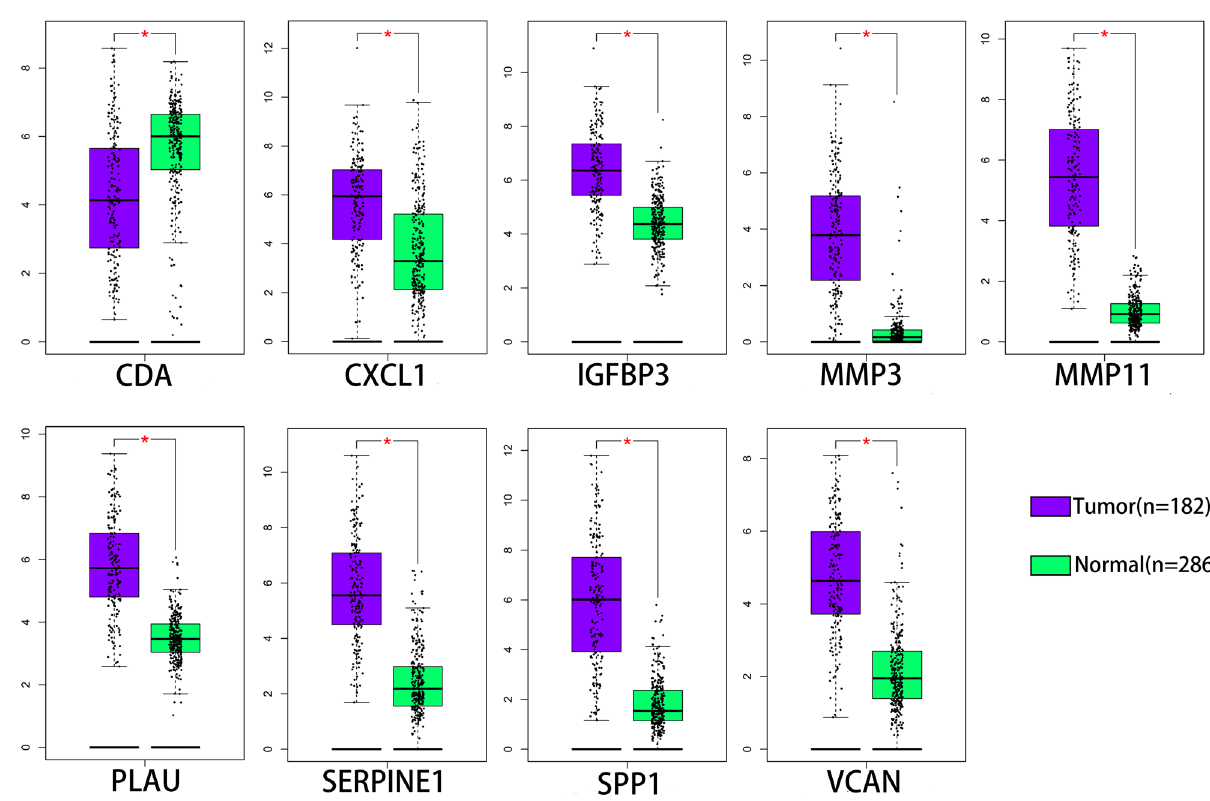
Figure 6. Expression of hub genes in ESCA tissues and normal tissues from the GEPIA database. ESCA, Esophageal carcinoma; GEPIA, Gene Expression Profiling Interactive Analysis. * P < 0.01 was considered statistically